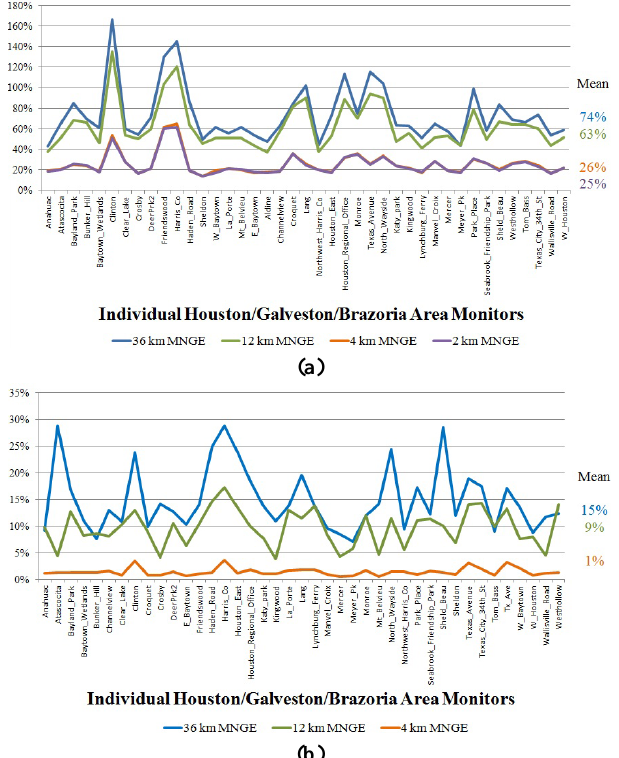
Fig. 2. (a) : Mean Normalized Gross Error (MNGE) comparing CAMx results for four grid resolution runs for the 2006 base case to measured concentrations at all air quality monitor sites in the HGB area. Bias (MNB) and error (MNGE) results are approximately the same due to a high bias of the model, so only MNGE is shown in (a) . Results are shown for 36km (blue line), 12km (green line), 4km (orange line) and 2km (purple line). 4km results are very similar to 2km results and as a result are mostly hidden by the 2km line. (b) : Difference between modeled “coarse” resolution ozone con- centrations (36, 12 and 4km) and modeled 2km “fine” resolution ozone concentrations calculated using Eq. (2) – MNGE.